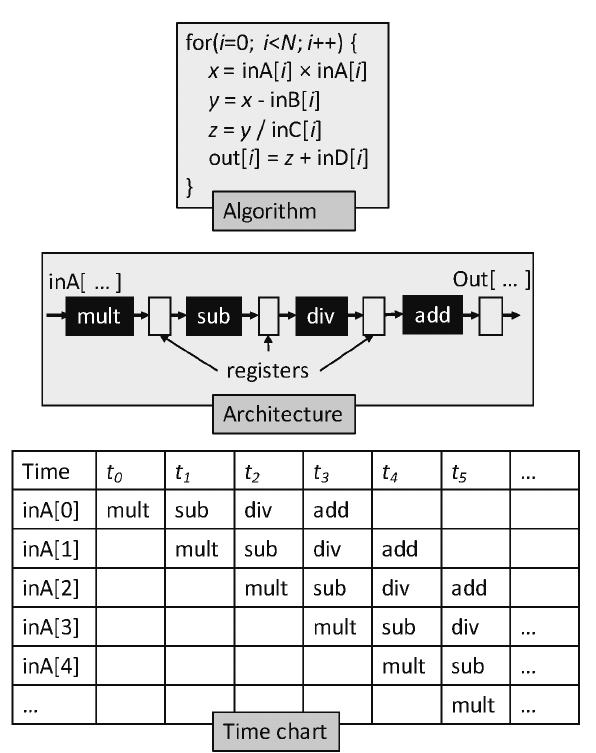
Fig. 4. Parallel processing using pipelines. Multiple opera- tions are done on different data simultaneously.